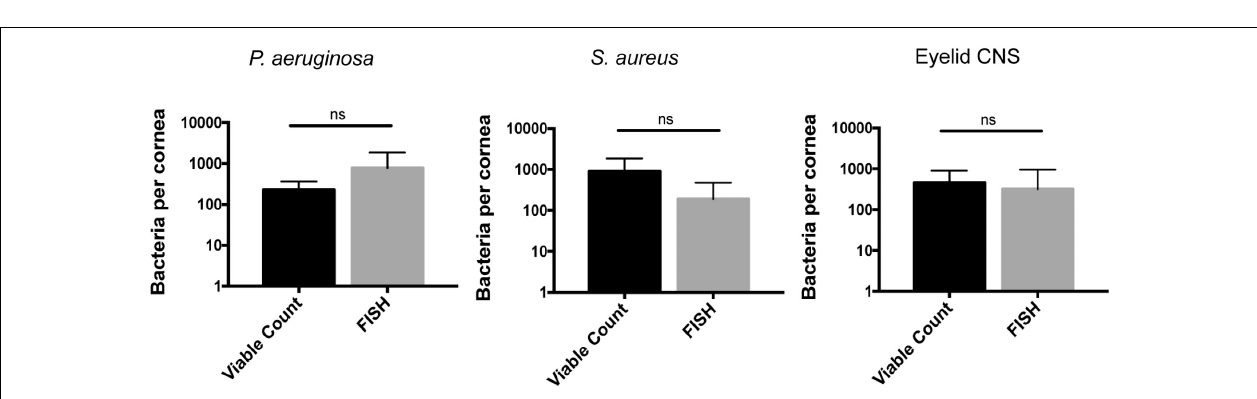
FIGURE 5 | Bacterial clearance from the murine ocular surface. Eyes of C57BL/6 mice were inoculated in vivo with P. aeruginosa, S. aureus, or a CNS sp. previously isolated from a mouse eyelid, to determine if bacteria could persist on the ocular surface. Data was expressed as the mean ± SD of viable bacteria recovered from the cornea, conjunctiva, or eye wash (see section “Materials and Methods”). The dashed line represents initial inocula. (A) After 24 h, the vast majority of inoculated bacteria ( ∼ 10 8 CFU) were cleared from the cornea, conjunctiva, and eye wash. (B) By 72 h (3 days), virtually all bacteria were cleared from the ocular surface. (C) A lower inoculum ( ∼ 10 4 CFU) resulted in few remaining bacteria after 24 h. In each instance, P < 0.05 compared to the initial inoculum (Kruskal–Wallis test, with Dunnett’s multiple comparison).